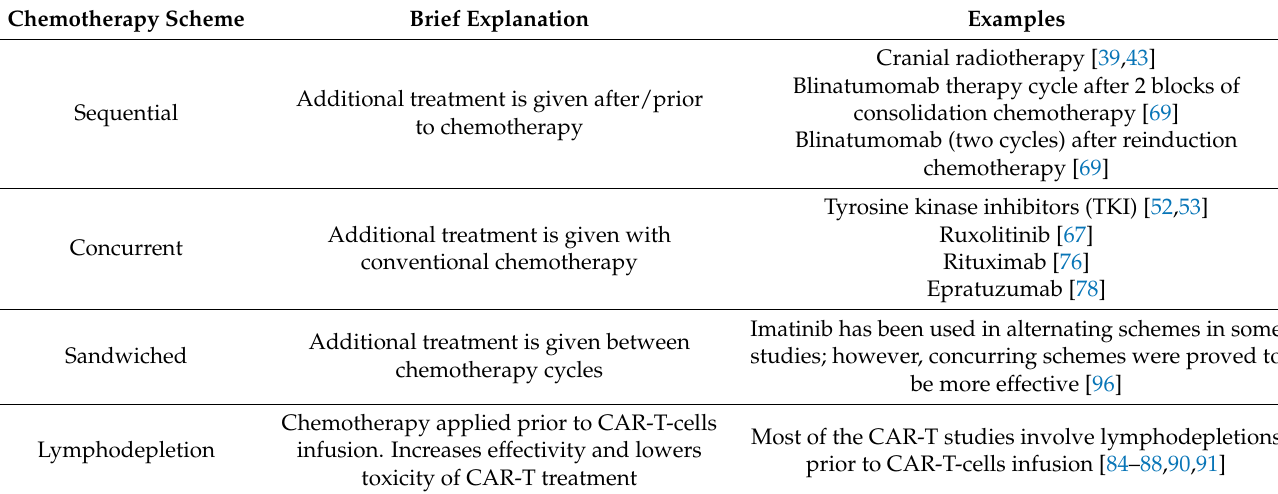
Table 3. Different forms of combined therapy in